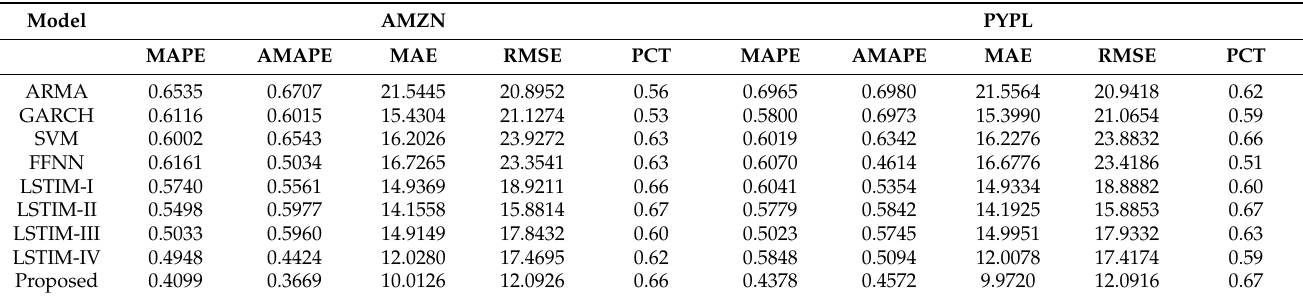
Table 8. Prediction performance for 75 days: AMZN and PYPL.